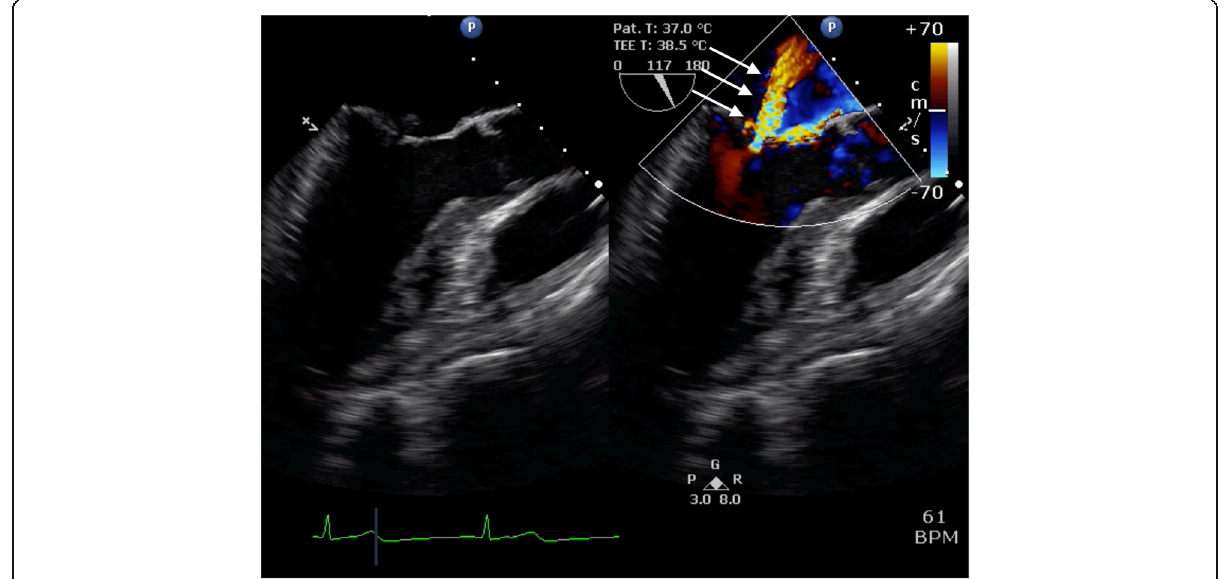
Fig. 2 Clockwise rotation of probe in the mid-esophageal long-axis view shows normal configuration of the mitral leaflets (A3-P3), however, a color Doppler image reveals a central mitral valve regurgitation jet with unknown etiology (white